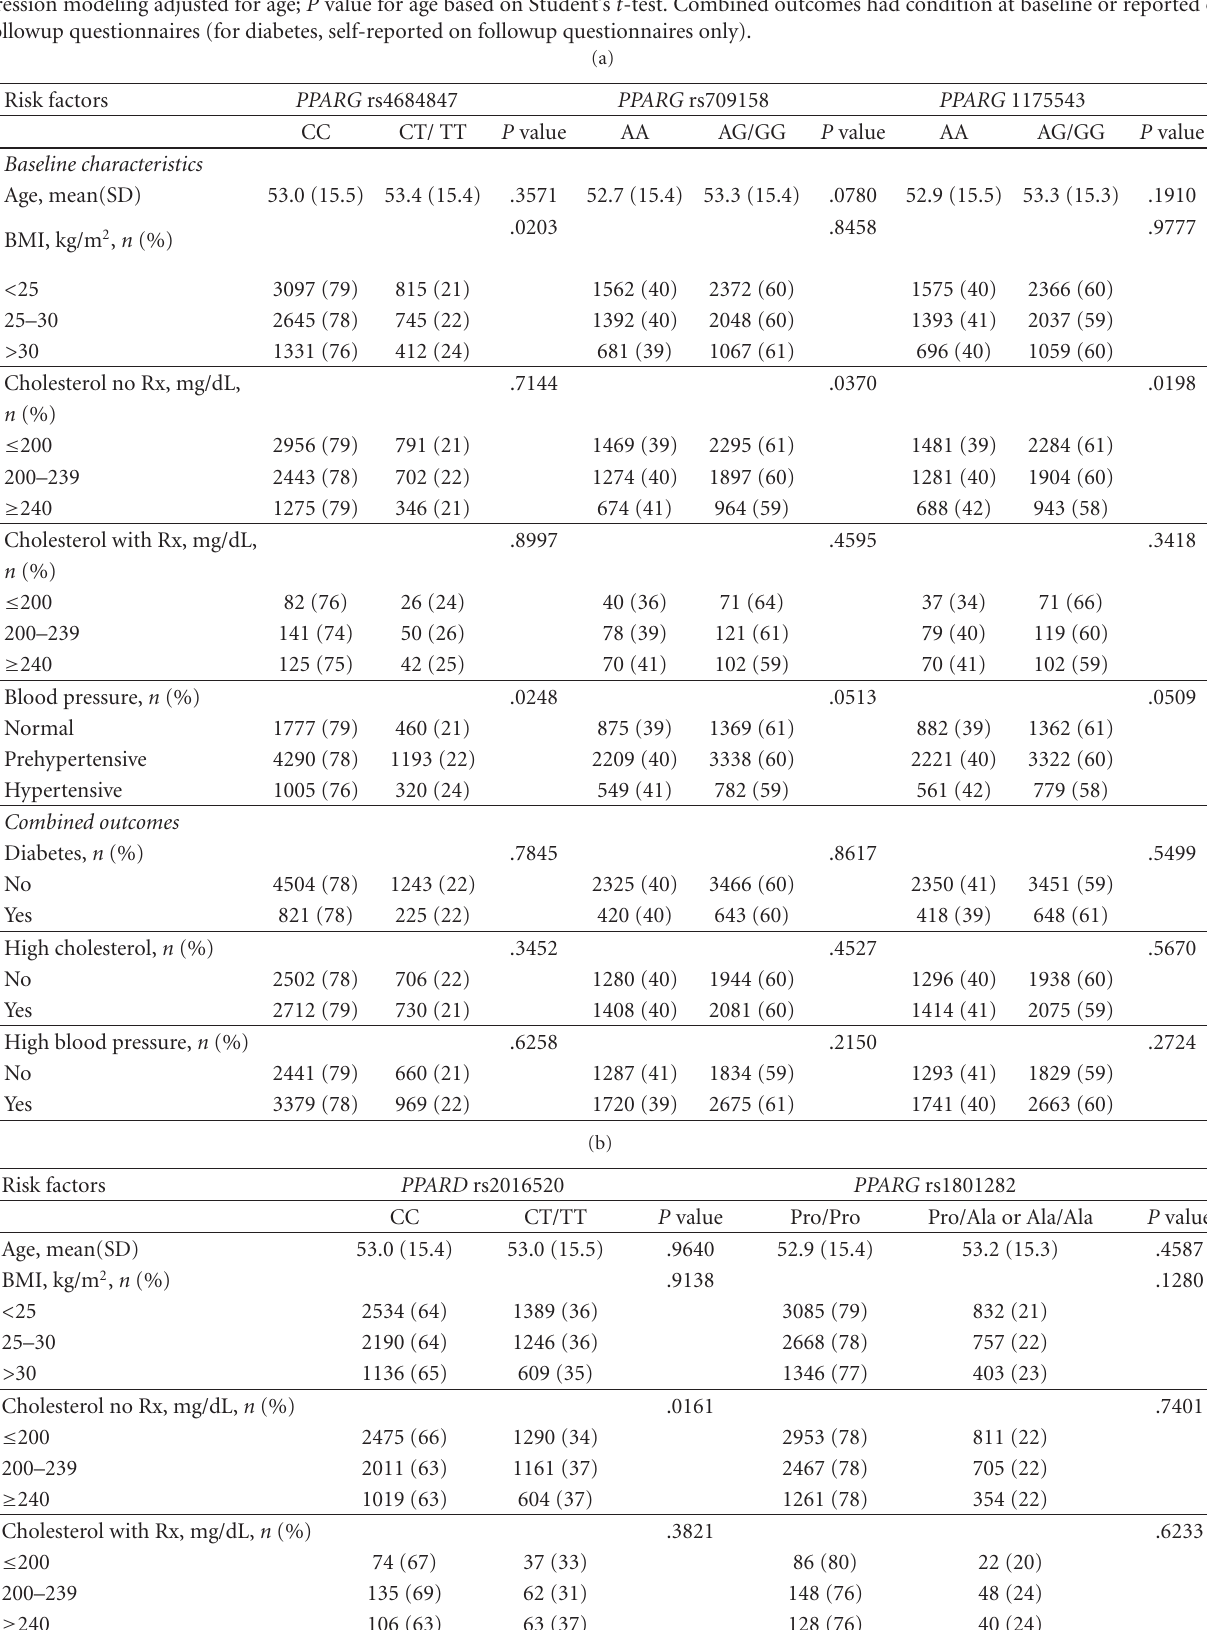
Table 2: The associations between PPAR SNPs and cardiovascular risk factors. Goodness of fit likelihood ratio P value using logistic re- followup questionnaires (for diabetes, self-reported on followup questionnaires